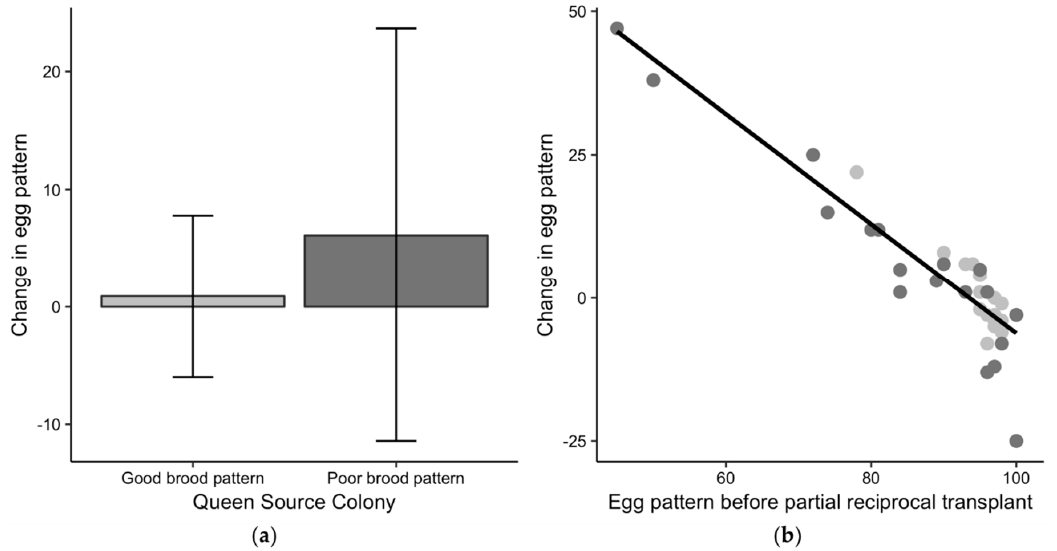
Figure 5. Changes in egg pattern for the partial reciprocal transplant experiment in 2017. ( a ) Comparison of the change in the egg pattern—a queen’s egg pattern after the exchange minus her egg pattern before the exchange—to the initial sealed brood pattern classification of good (light grey) or poor (dark grey). Positive values for the change in egg pattern indicate that the brood pattern improved after the exchange and negative values indicate the pattern was worse after the exchange. ( b ) The potential for change in egg pattern based on variability in the starting egg patterns.